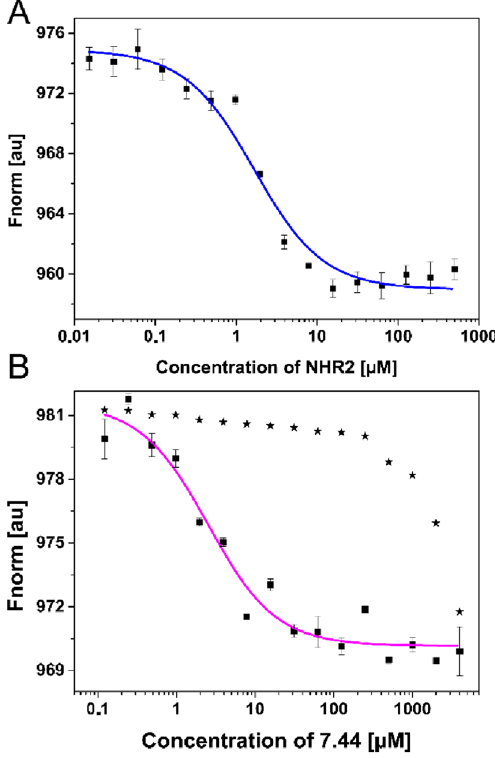
Figure 3. 7.44 binding to NHR2 detected with MST. ( A) Titration of unlabeled NHR2 to a constant concentration of labeled NHR2 induces a change in thermophoresis. K tet = 1.60 ± 0.32 µM was calculated using Eq. (2). ( B) Titration of 7.44 to a constant concentration of labeled NHR2 induces a change in thermophoresis, shown in square symbols. EC 50 was calculated by fitting the data points to Eq. (3). The fitted values are shown in Table 1. The range of Hill coefficients n = 1–1.5 was obtained from the fits. When titrating 7.44 to a constant concentration of labeled Histag-SUMO-M5 variant (all five hotspot residues were mutated to alanine), the magnitude of the thermophoresis appears to be the same, but the affinity is about three orders of magnitude lower (shown in star symbols). Error bars denote the standard error in the mean and were calculated from technical